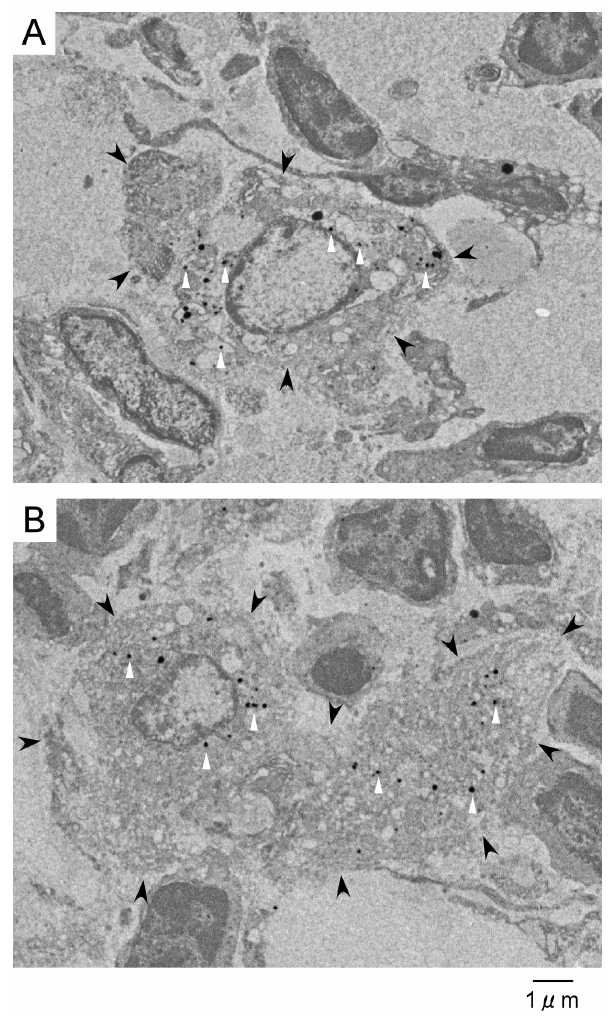
Figure 6. Electron microscopic images of phagocytes in inguinal lymph nodes. (A) A macrophage in inguinal lymph nodes with silica coated fluorescent nanoparticles injection (Black arrow head; the outline of the macrophage, white arrow head; the silica coated fluorescent nanoparticles). (B) A dendritic cell in inguinal lymph nodes with silica coated fluorescent nanoparticles (Black arrow head; the outline of the dendritic cell, white arrow head; the silica coated fluorescent nanoparticles).